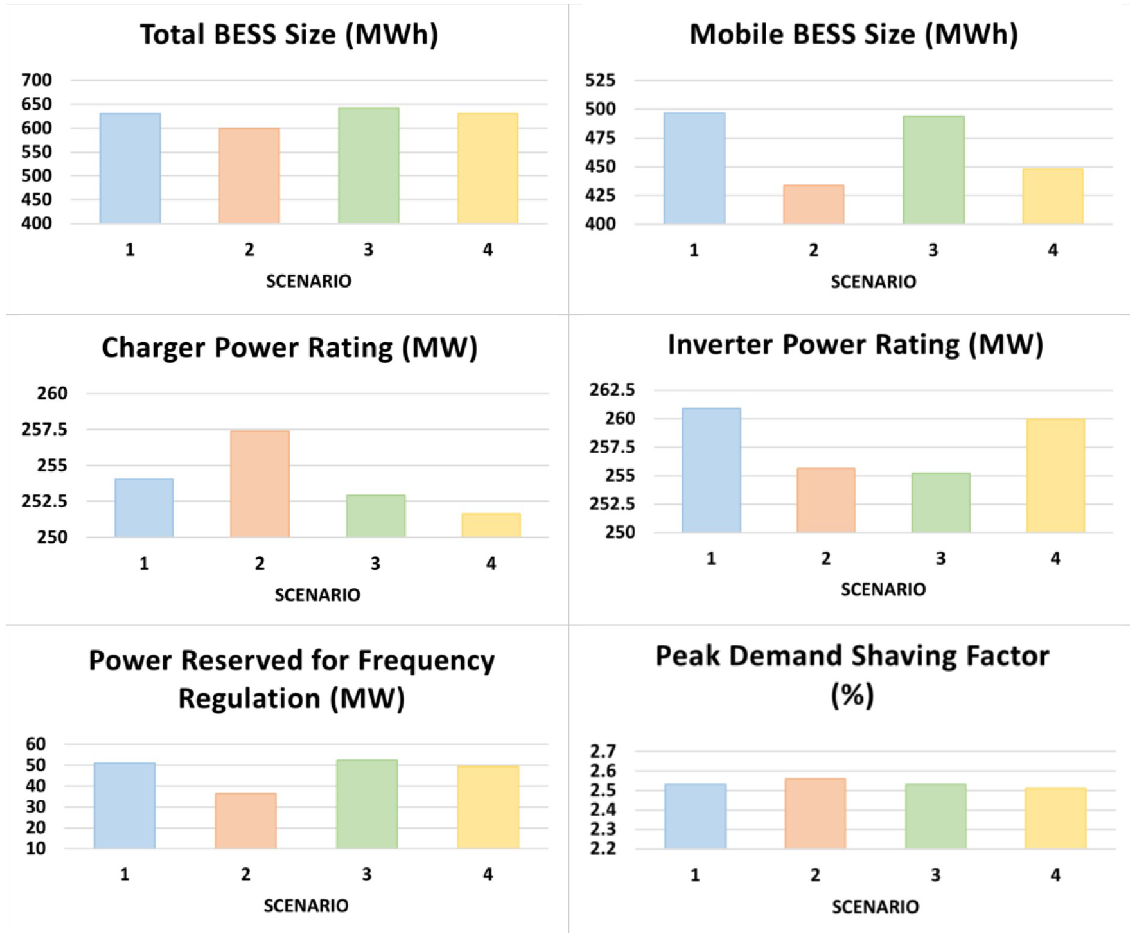
Fig 9. Optimized sets of the six control variables in four different scenarios (1, 2, 3, 4) under the AC priority operation mode.